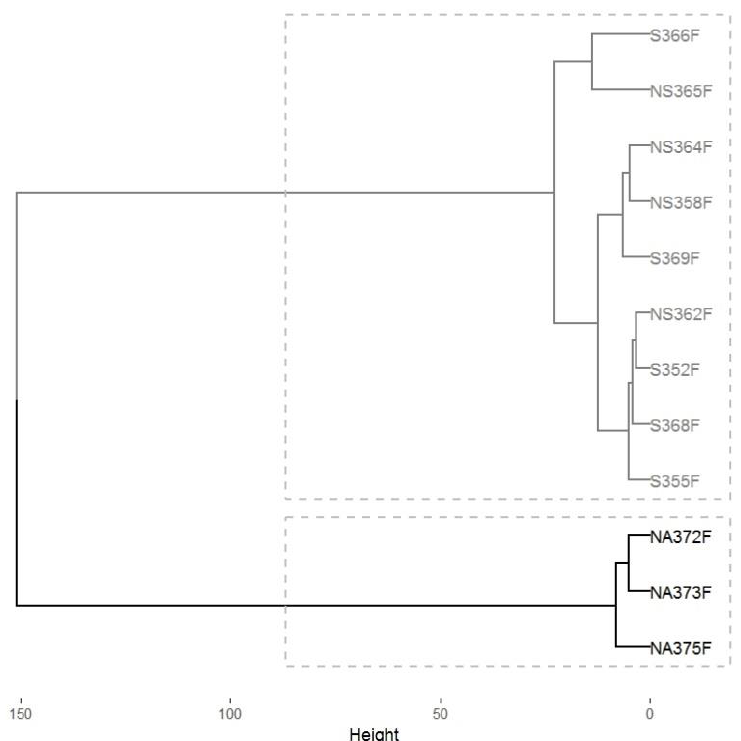
Figure 2. K-means cluster dendrogram for the terpenoid composition in the phloem–cambium tissue samples. Dotted-line rectangles indicate the k-means clustering groups. Numbers correspond to the pine sample identification and letters before each code represent the disease degree (NA: non- symptomatic pines in healthy stands, NS: non-symptomatic pines within declining stands, S: symptomatic pines within declining stands).